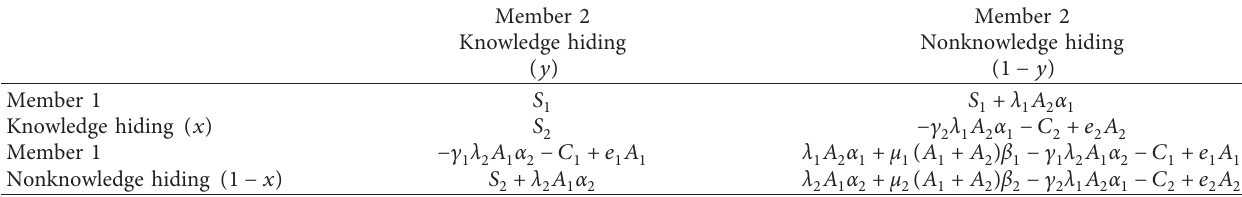
Table 2: Game model-based payoff function matrix of knowledge